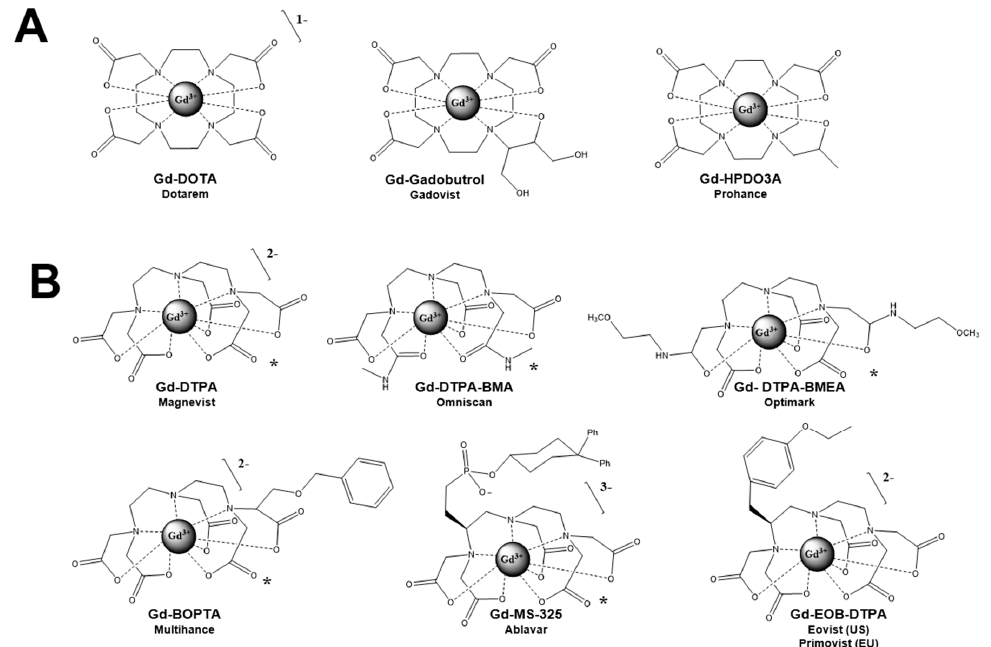
Figure 3. Schematic representation of Gd 3+ -based contrast agents commercially approved and used in the clinic: ( A ) polyaza macrocycles, ( B ) linear aminopolycarboxylates. Corresponding overall charges represented at the top right corner of each agent. All the agents are coordinated to one water molecule that is not represented here, for simplicity. CAs labeled with * were suspended by the European Medicines Agency due to concerns over nephrogenic systemic fibrosis. Note that all starred agents are linear, not macrocyclic, compounds.